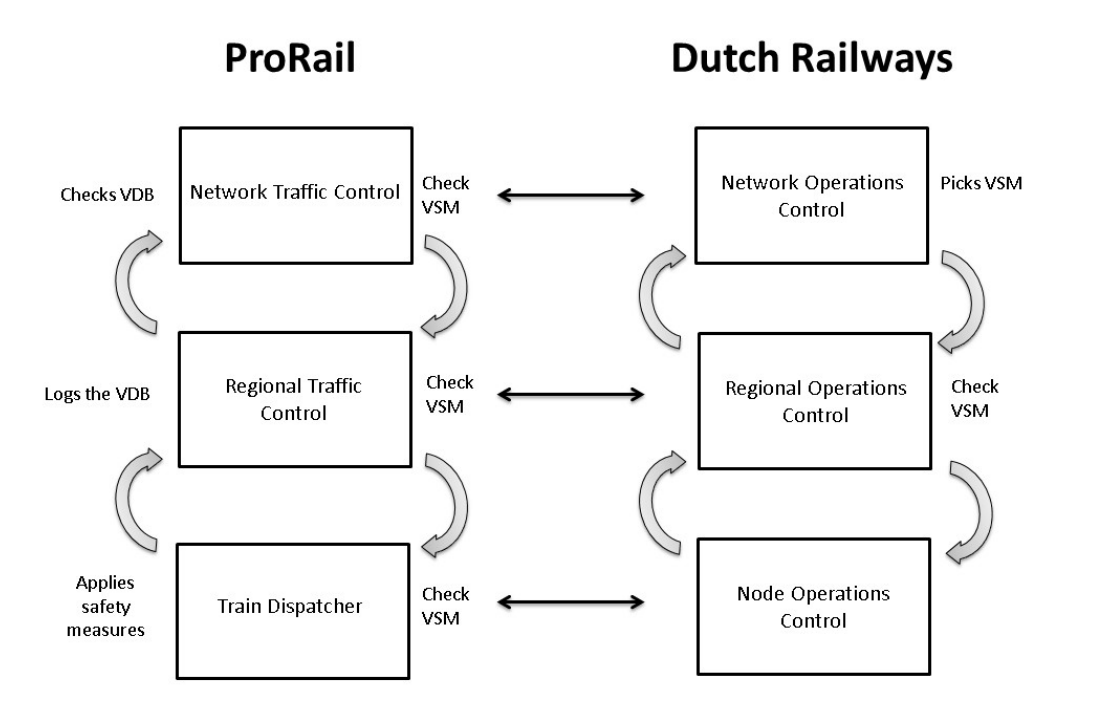
Figure 1. Communication flows during a disruption between ProRail and Dutch